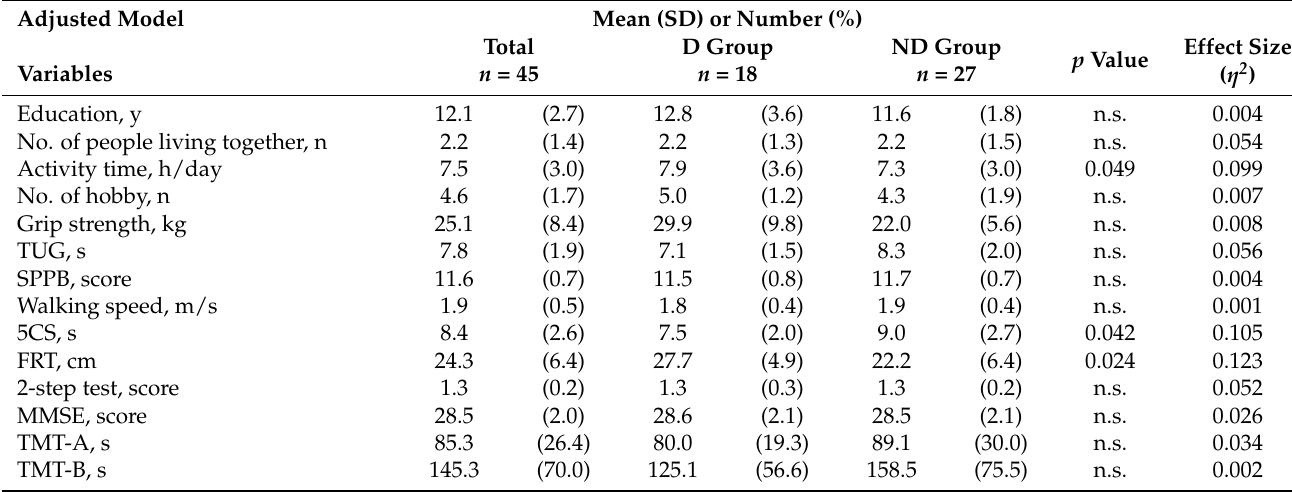
Table 3. Comparison between the two groups adjusted for age and